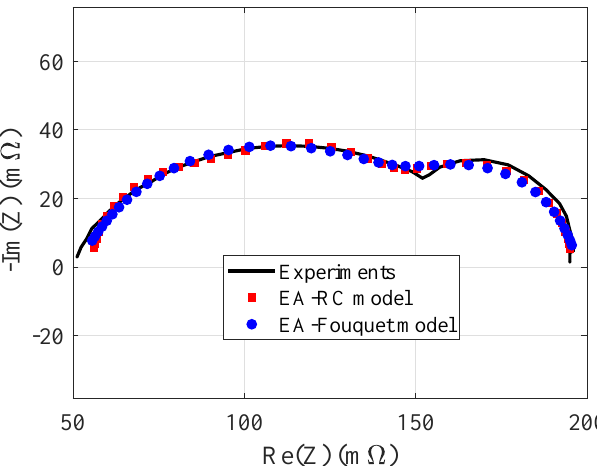
Figure 6. Dataset A. Results achieved by the EA in the identification of RC and Fouquet models.